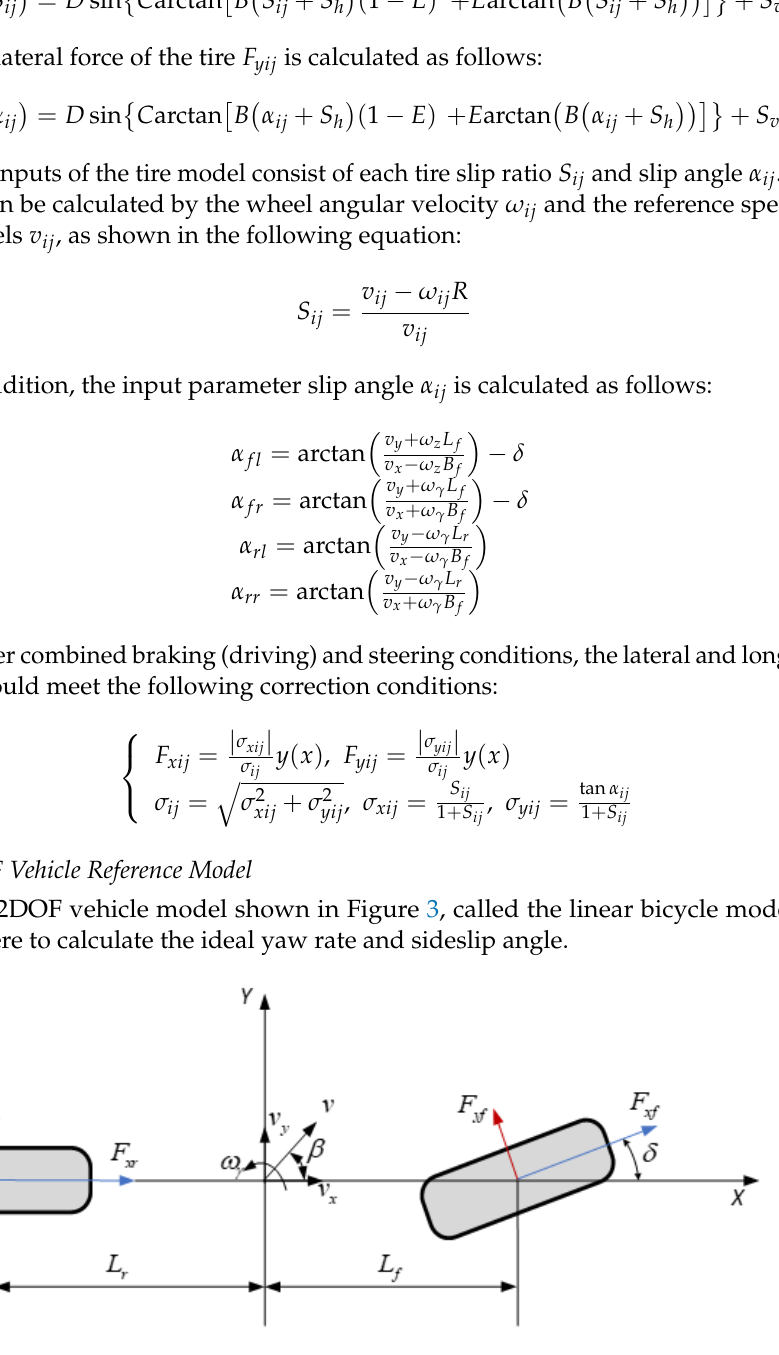
Figure 3. Schematic diagram of 2DOF vehicle model.